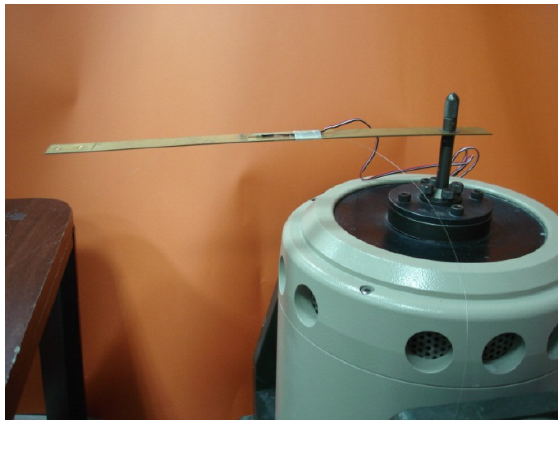
Figure 6. Cantilever beam mounted on a shaker.